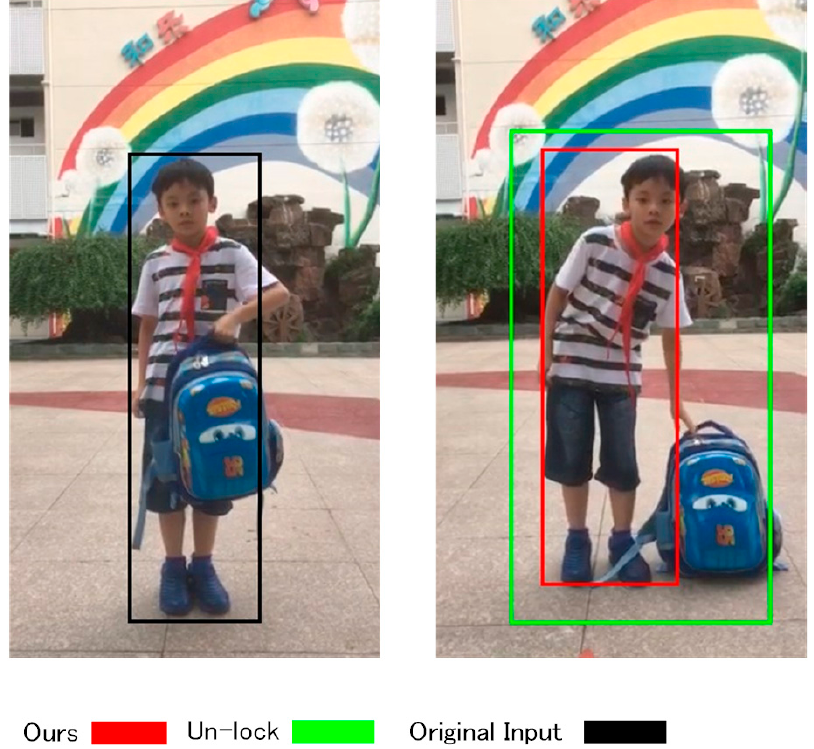
Figure 1. Person localization samples. The un-lock marker depicts the results without a classification-lock strategy, and the red marker depicts the classification-lock strategy.